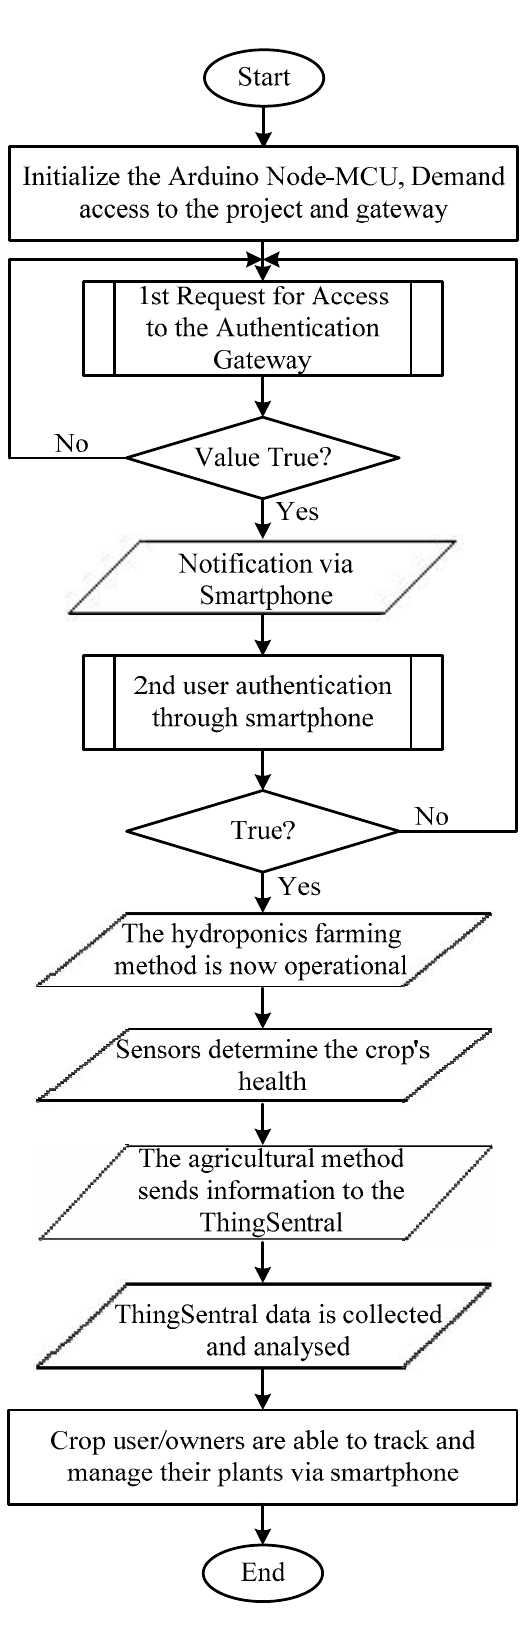
Figure 16. The flowchart’s overall design using a 2FA mechanism.